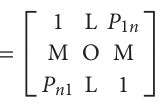
A judgment matrix F n × n with the ratio of interval values is written as Eq. 3, where P 1 n represents the ratio of the interval value for the first factor and the interval value for the nth